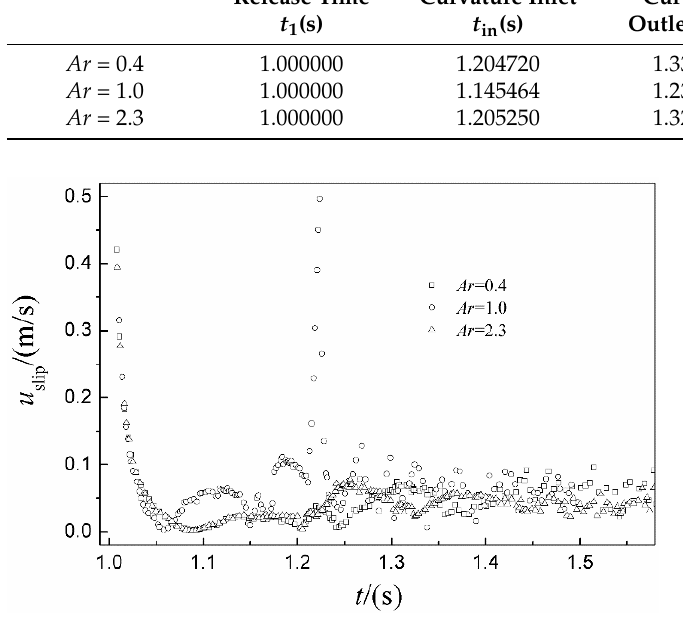
Figure 14. Effects of Ar on particle slip velocity.